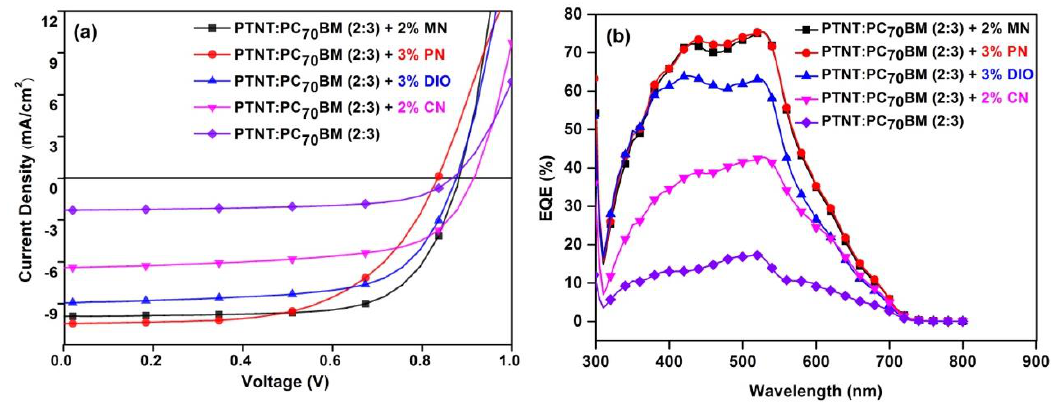
Figure 2. Photovoltaic devices with and without solvent additives: ( a ) representative current density–voltage curves; ( b ) EQE versus wavelength.